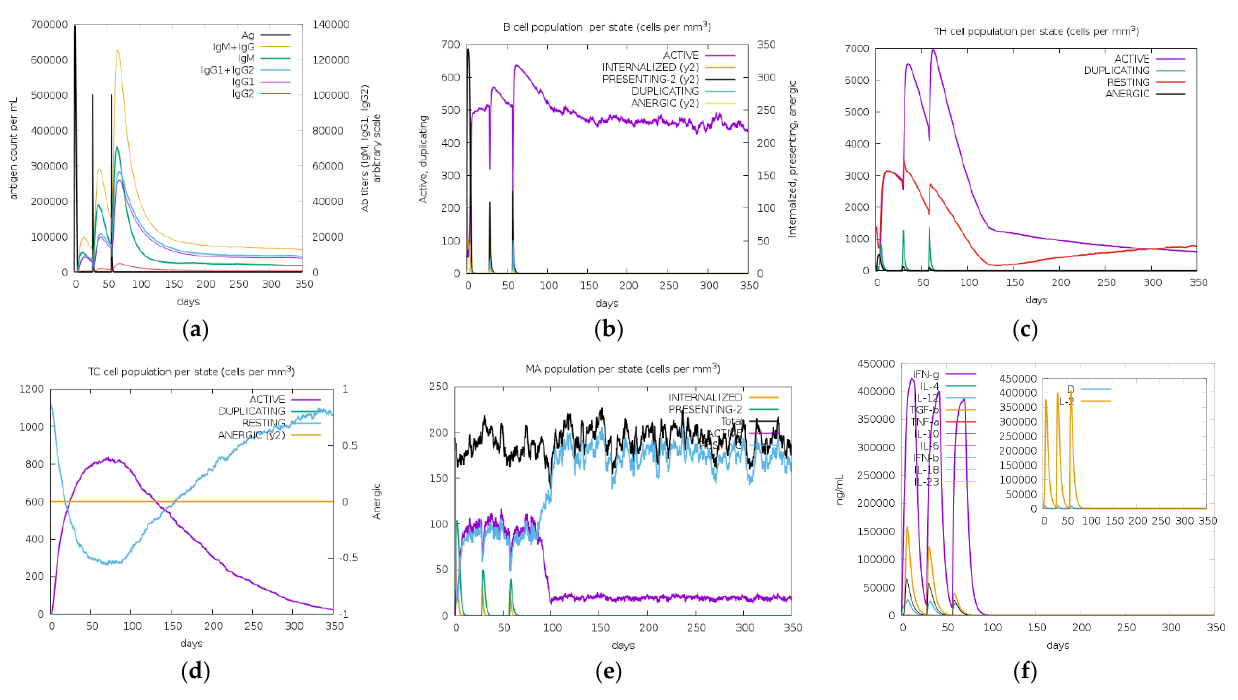
Figure 10. In silico immune simulation of the B.1.1.7 vaccine using C-ImmSim server. Antigen and immunoglobulins ( a ), B cell population ( b ), TH cell population ( c ), TC cell population ( d ), macrophage population ( e ), production of cytokine and interleukins with Simpson index ( f ). Alongside immune simulation, codon optimization was performed for the three vaccine candidates. In this work, the codon optimization used was based on Escherichia coli